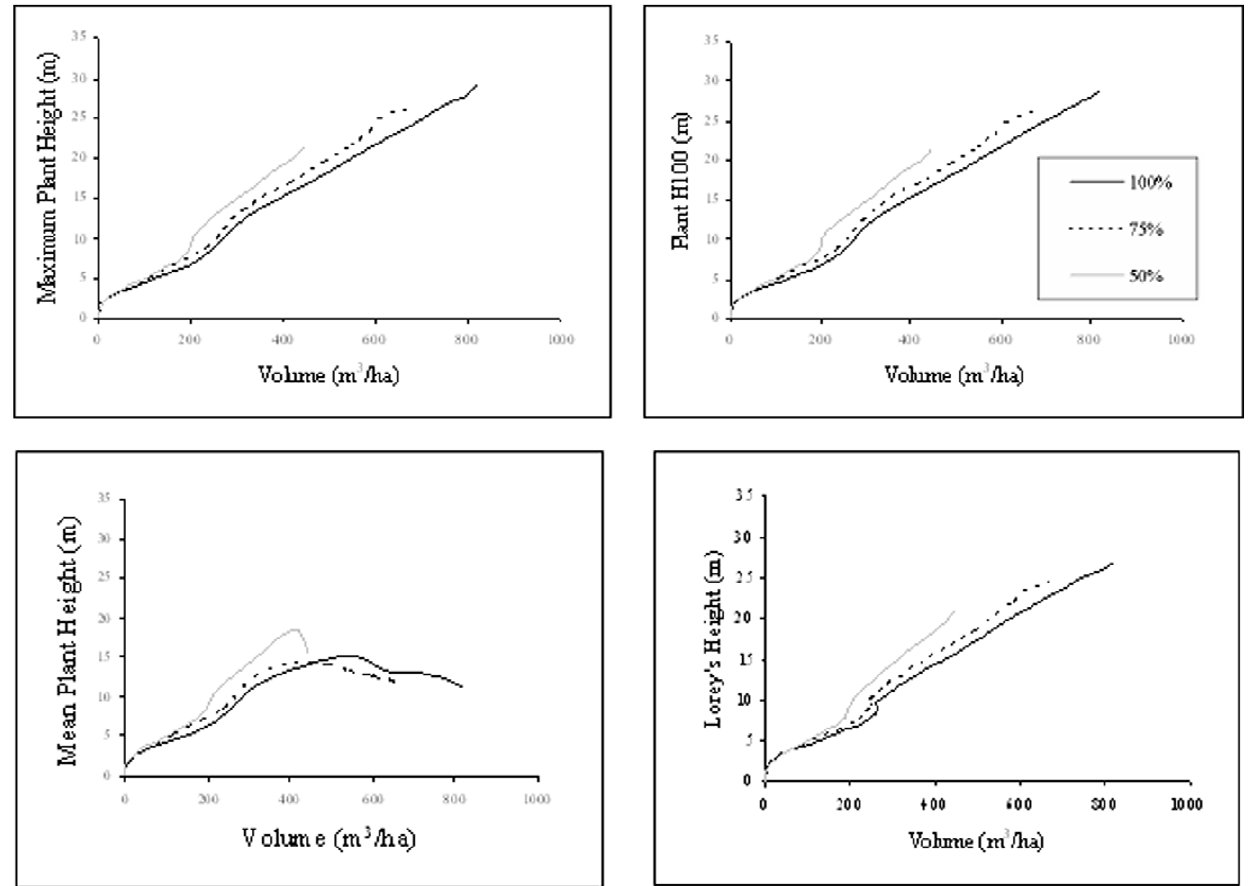
Figure 10. AbiesAlba stands of planting density 10000 ha 2 1 exposed to variations in light intensity (100%, 75%, 50%). Data shown clockwise for H max , H 100 , H Lorey and H mean .